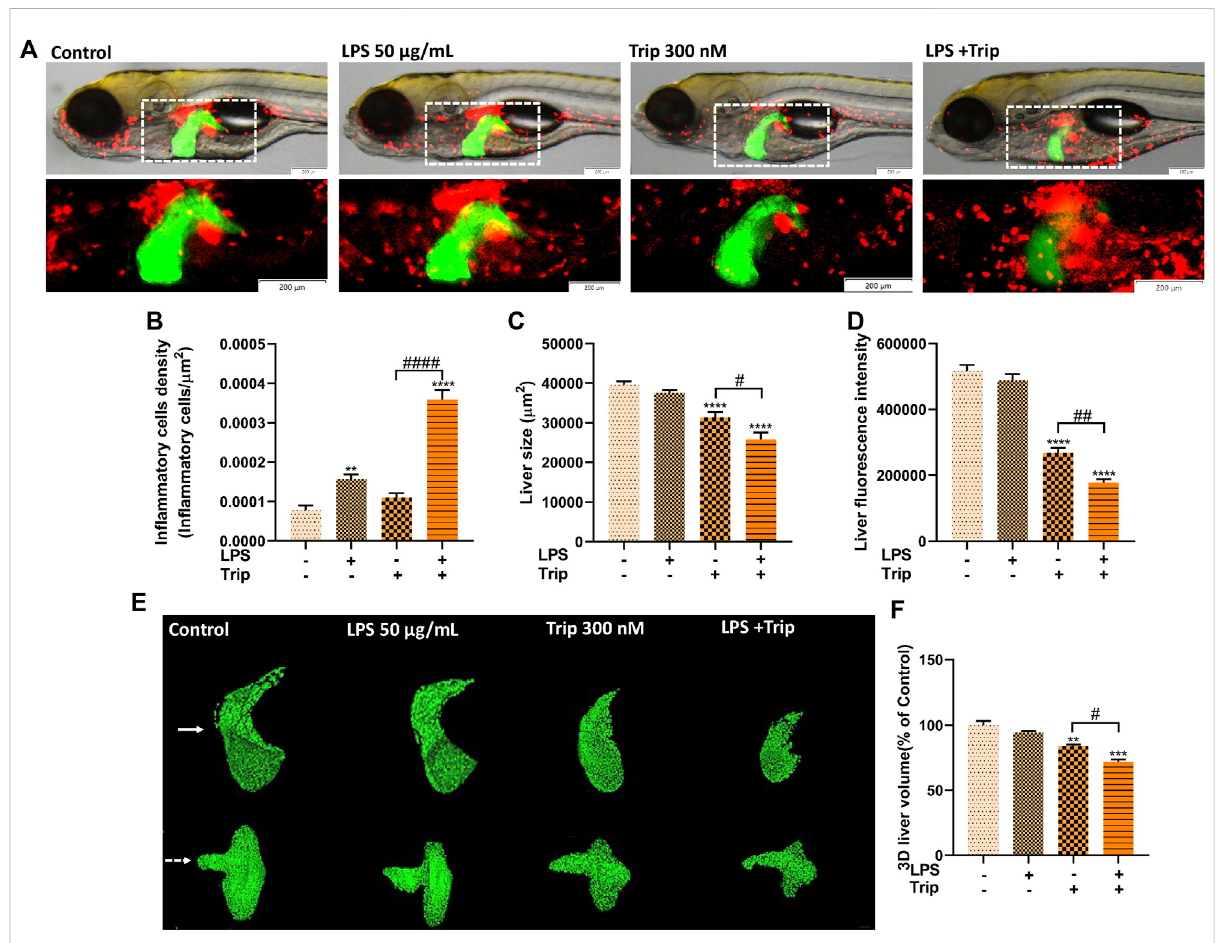
FIGURE 1 The effect of triptolide on the in fl ammatory cells and liver morphology after the stimulation of LPS. (A) Morphological changes in the liver and distributionofin fl ammatorycellsinzebra fi sh.Green fl uorescencerepresentstheliver;red fl uorescencerepresentsin fl ammatorycells. (B) Densityof in fl ammatory cells in the liver. (C) Liver fl uorescence area. (D) Liver fl uorescence intensity. (E) Liver 3D morphology. (F) Liver 3D volume. The larvae are photographed with their heads to the left and their eyes overlapping in a side-lying position. The white arrow points to a 3D stereoscopic front view of the liver in direct view. The white dashed arrow is a 3D stereoscopic elevation view of the liver viewed from the abdomen. **p < 0.01, ***p < 0.001, ****p < 0.0001 vs. the blank control group. #p < 0.05, ##p < 0.01, ####p < 0.0001 vs. the Triptolide (Trip)